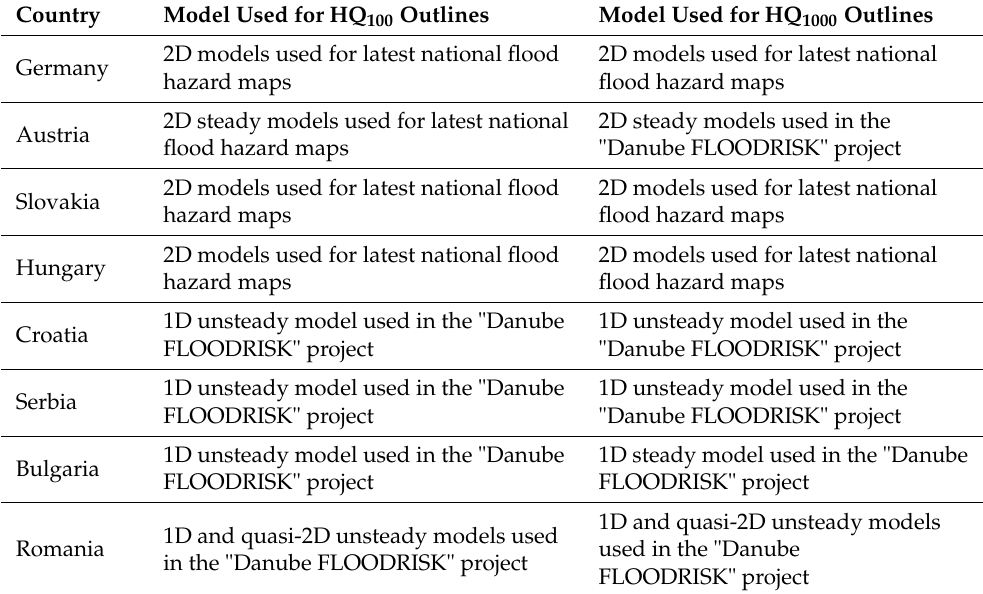
Table 2. Overview of the hydraulic models that were used to calculate the inundation areas for HQ 100 and HQ 1000 in each country. Country Model Used for HQ 100 Outlines Model Used for HQ 1000 Outlines 2D models used for latest national flood hazard maps 2D steady models used for latest national flood hazard maps